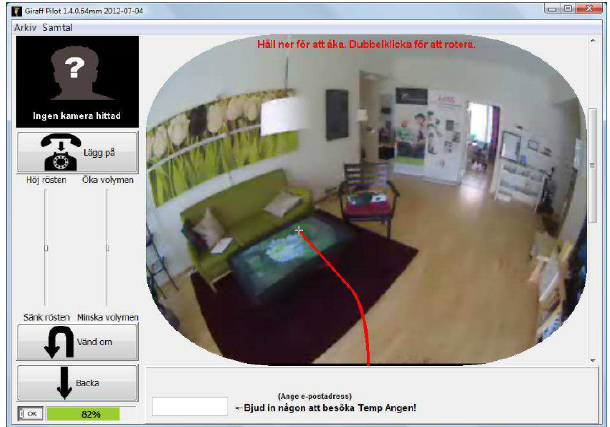
Figure 2. Giraff Pilot